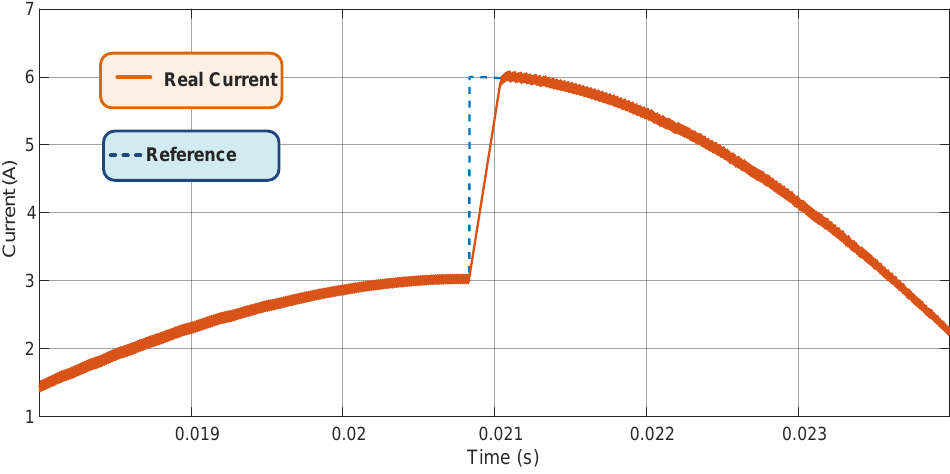
Figure 8. Comparison between currents 𝑖 1 ∗ and 𝑖 1 – in detail.